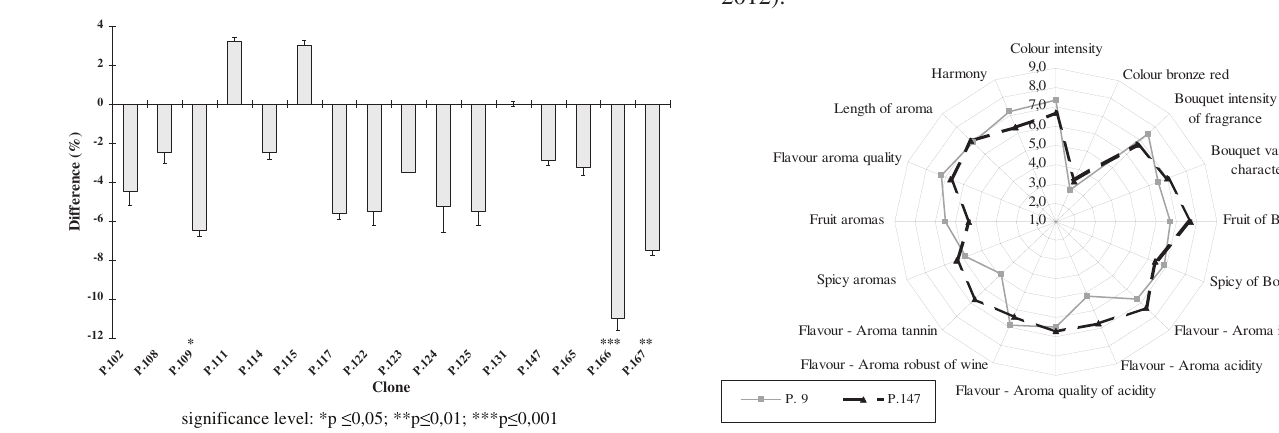
Figure 6. Divergences of the selected ‘Kadarka’ clones regarding the sugar content of the must from the P. 9 clone (Szekszárd - Batti field, 2011)